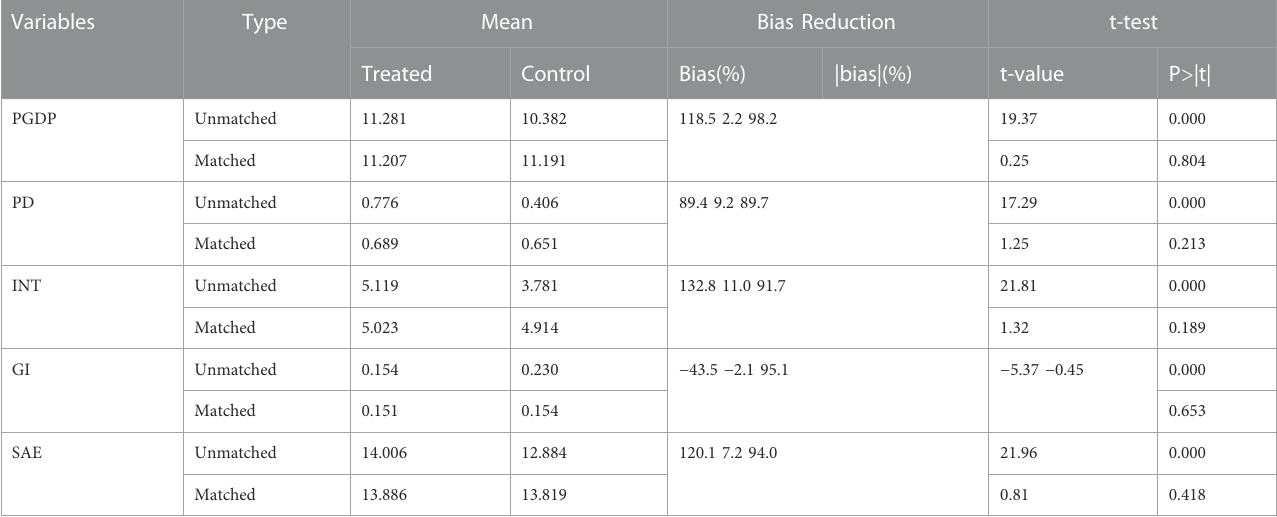
TABLE 7 Balance test and matching results.